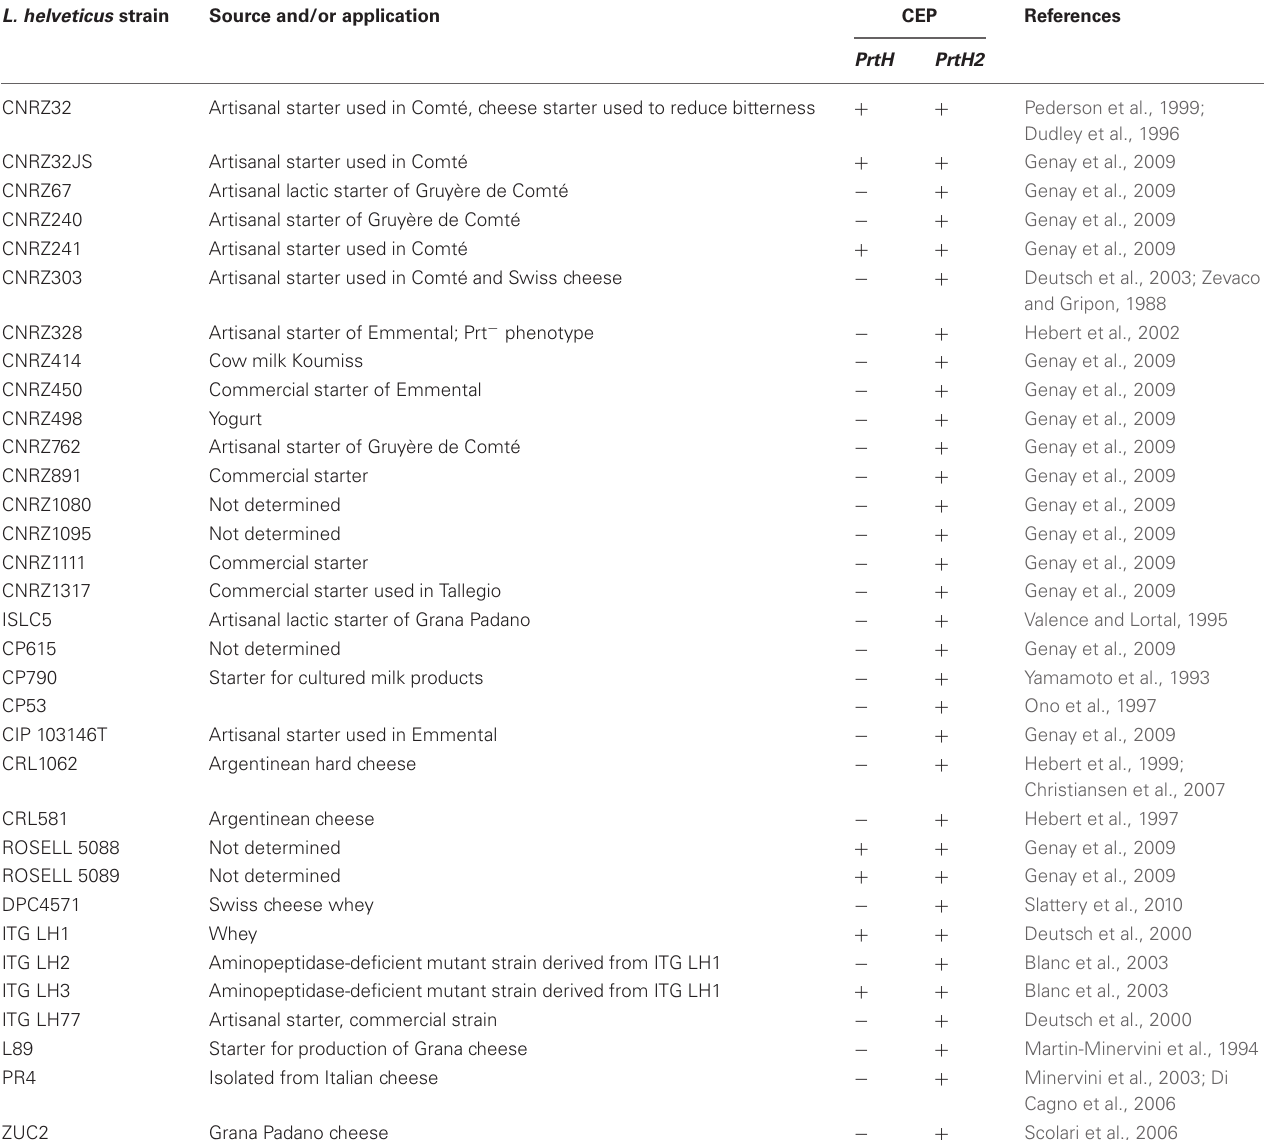
Table 1 | Cell envelope proteinases and origin of characterize L. helveticus